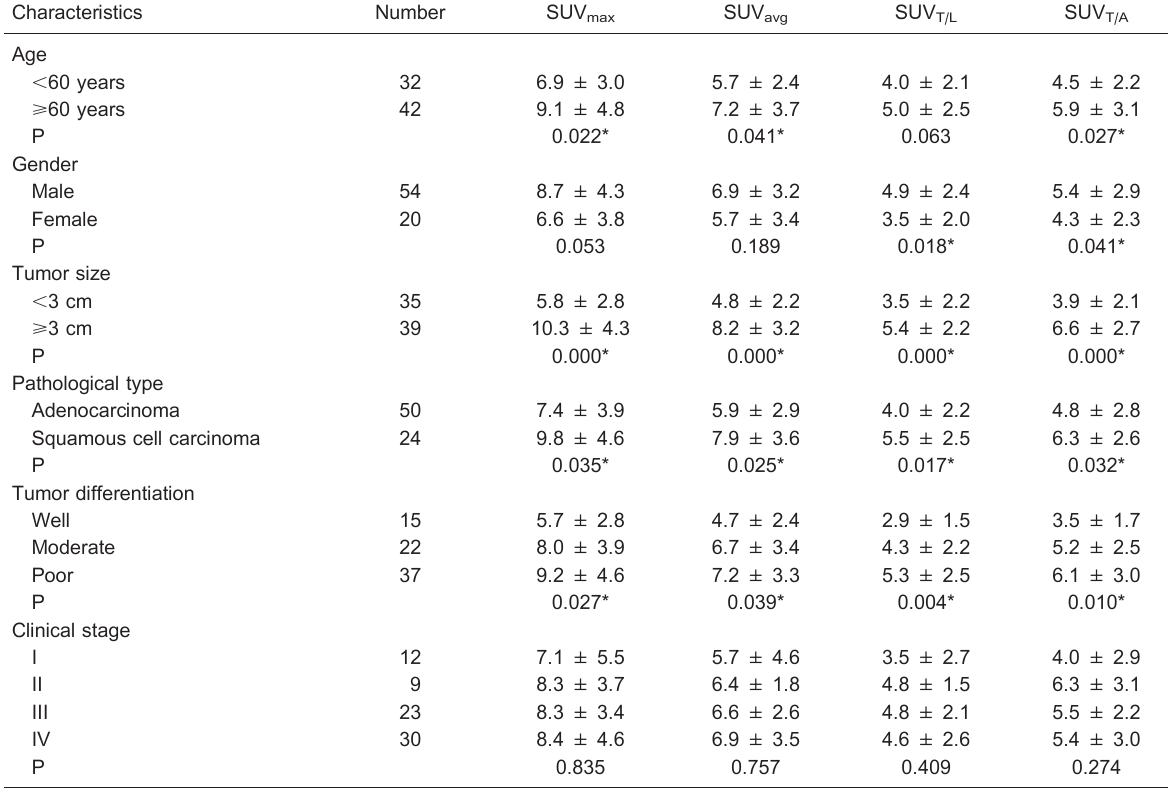
Table 1. Baseline characteristics and standardized uptake values (SUVs) of the study population (n=74). Characteristics